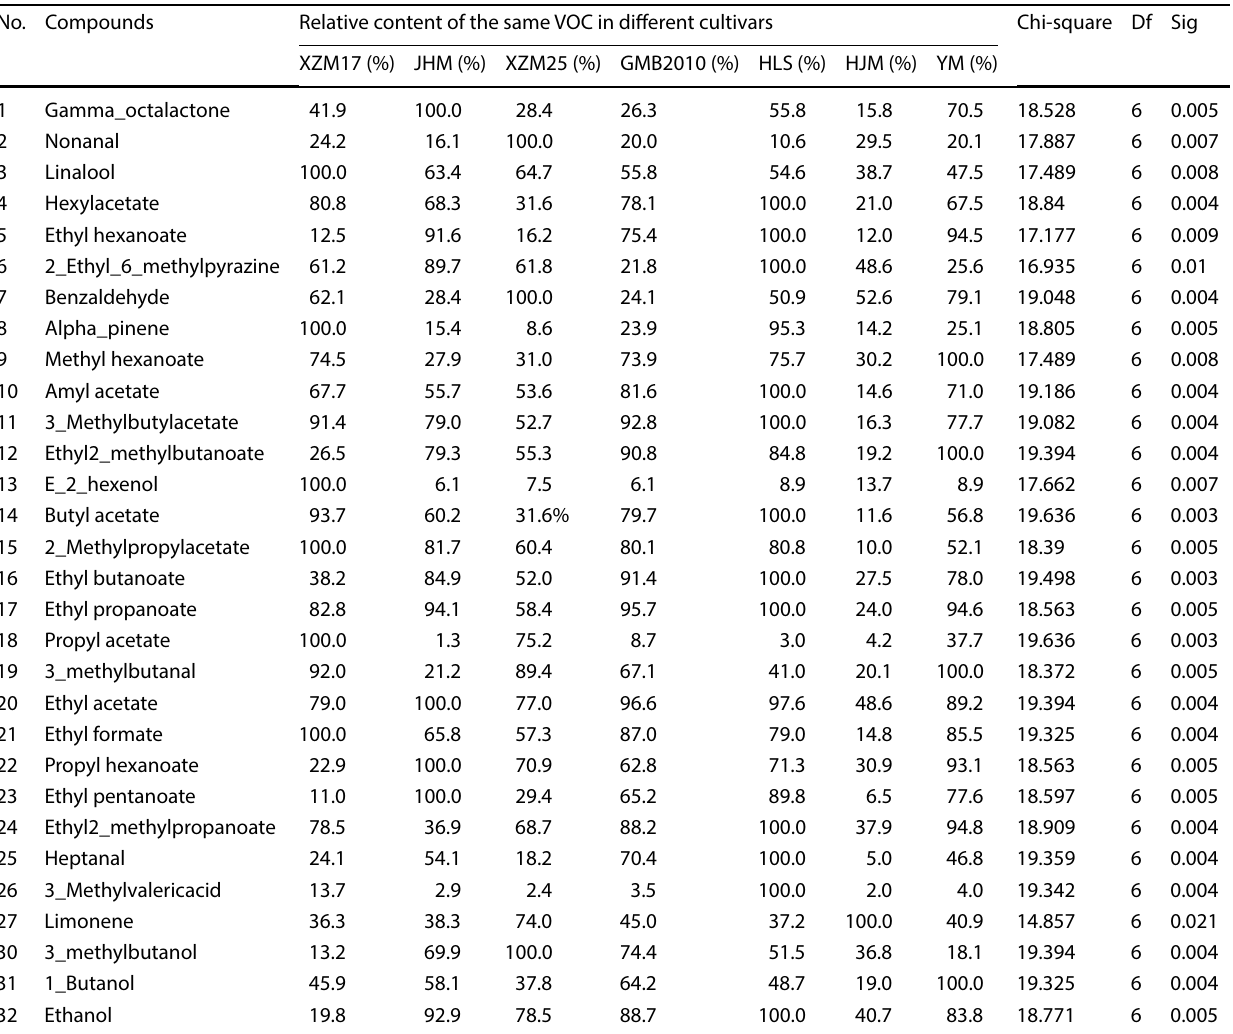
Table 3 Relative content of the same VOC in different cultivars No. Compounds Relative content of the same VOC in different cultivars Chi-square Df Sig